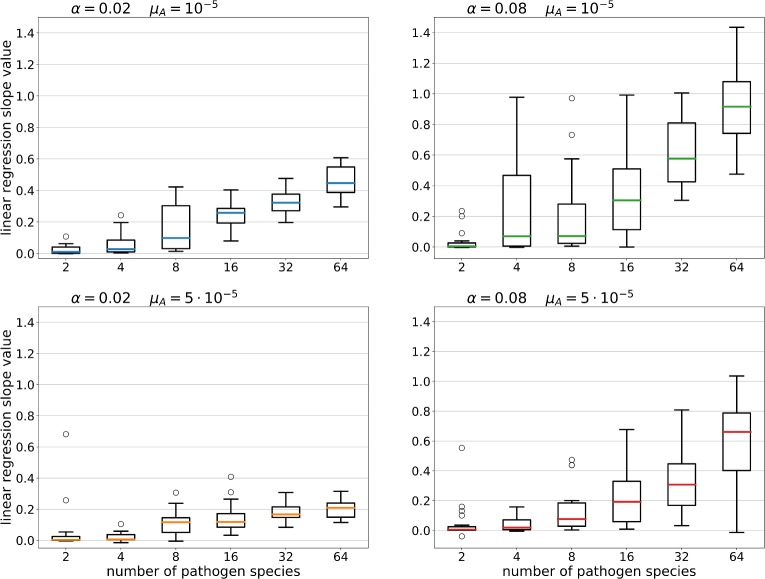
Coefficients of regression of INV on pathogen presentation ability for various combinations of parameters.For each simulation run we calculated the linear regression between the number of unique MHCs in individuals and the number of infections they were able to present to the immune system. Boxplots (median and quartiles) summarize the slopes of regression for each parametrization.